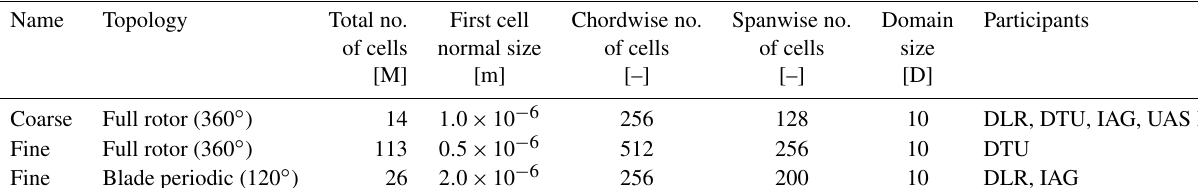
Table 3. Coarse and fine mesh properties.